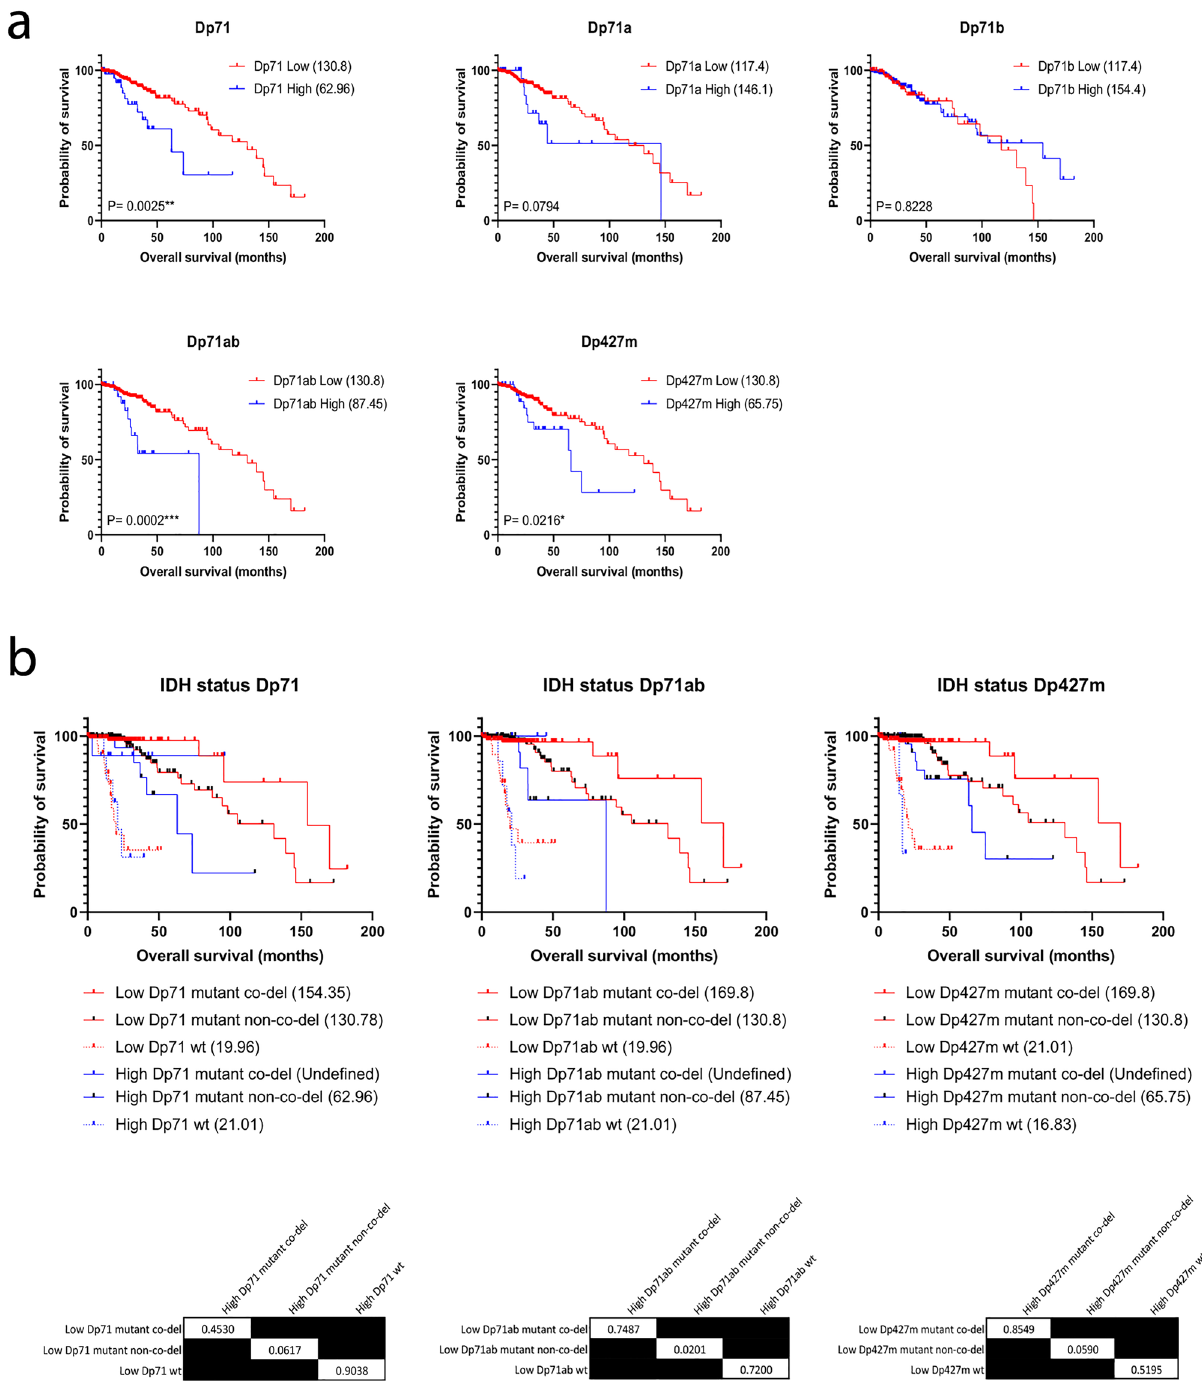
Figure 7. The expression of multiple DMD gene products are significantly associated with LGG survival outcomes. ( a ) LGG TCGA RNAseq data for each DMD isoform was dichotomised into high (blue) and low (red) expression groups and survival analysis performed in GraphPad using the log-rank test. Numbers in brackets are median overall survival times in months. ( b ) Kaplan–Meier survival curves for high (blue) vs low (red) Dp71, Dp71ab or Dp427m expression for each IDH mutation status group were compared. Numbers in brackets are median overall survival times in months. The tables provide the log-rank test P values for each planned comparison; the alpha value was adjusted to 0.017 to correct for multiple